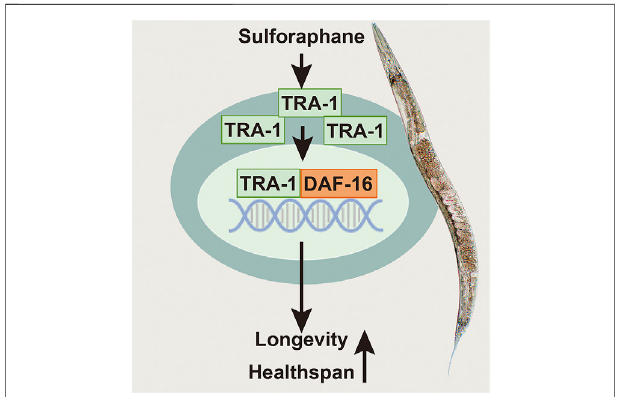
FIGURE 6 | Scheme of sulforaphane-promoted lifespan and healthspan by inducing TRA-1 and DAF-16 nuclear translocation. Sulforaphane induces enhanced protein levels of the TRA-1 terminal transcription factor of the C. elegans sex-determination pathway. TRA-1 translocates to the nucleus, where it binds to DAF-16, which is the main target of the insulin/insulin-like growth factor signaling pathway, plays a fundamental role in lifespan, metabolismandstressresponsesandisrelatedtothemobilityandfoodintake of C. elegans . We assume that this scenario is responsible for the observed sulforaphane-mediated extended lifespan and improved healthspan of C. elegans .